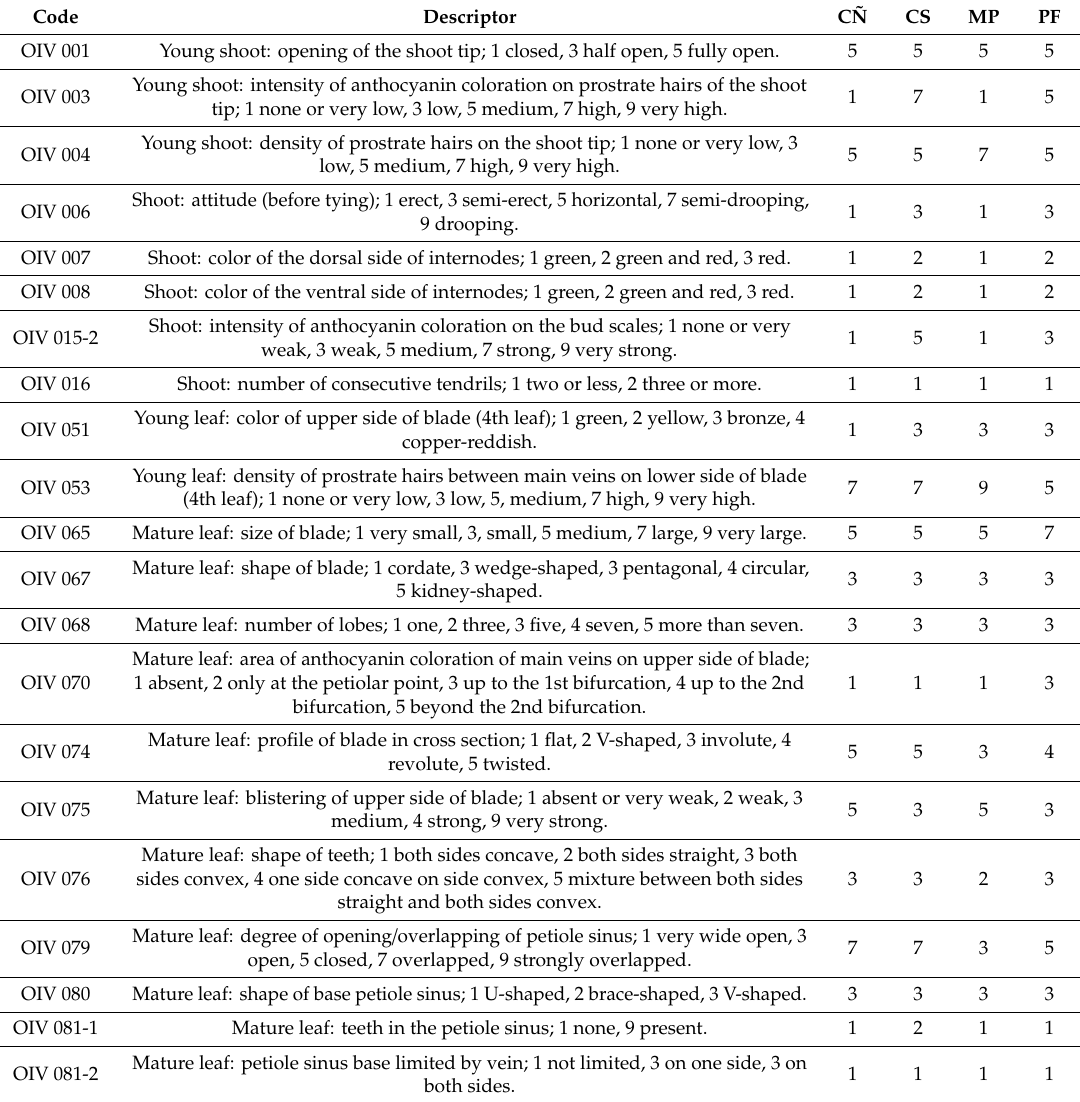
Table 2. Modal values for the International Organization of Vine and Wine (OIV) ampelographic descriptors observed in the four varieties analyzed during two consecutive